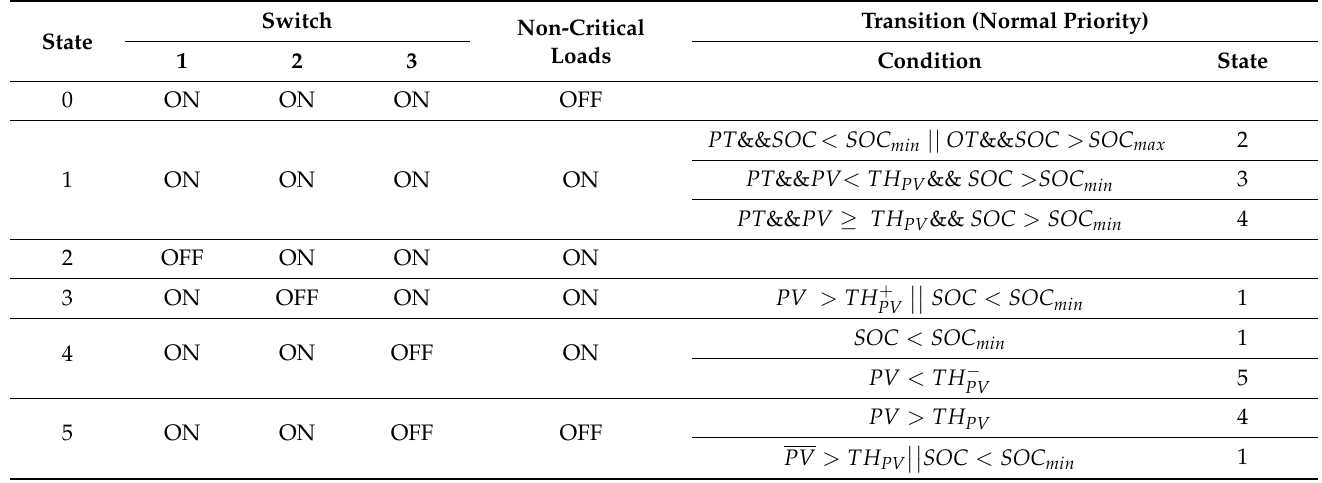
Table 1. Finite state machine transitions in normal priority.